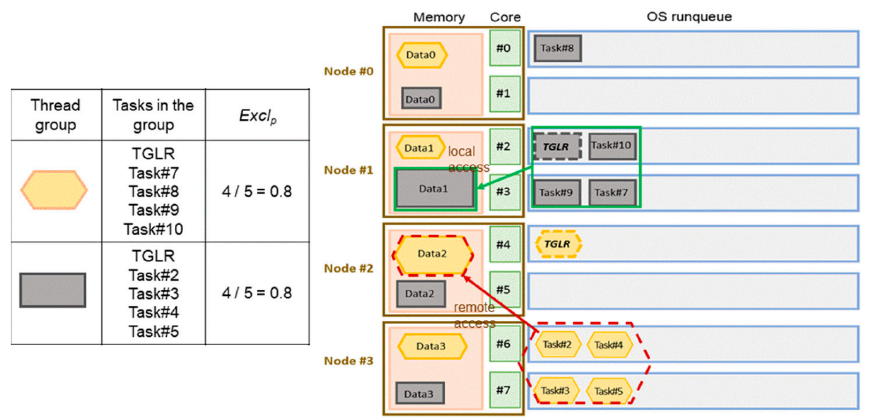
Figure 10. A highly exclusive thread group may involve much remote memory